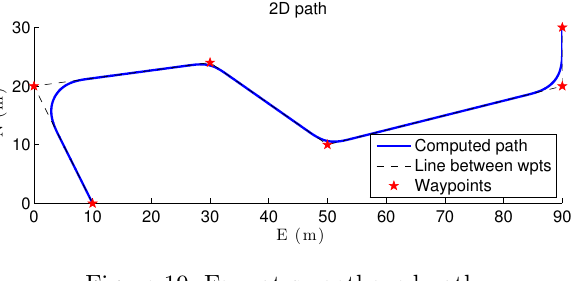
Figure 19: Fermat-smoothened path